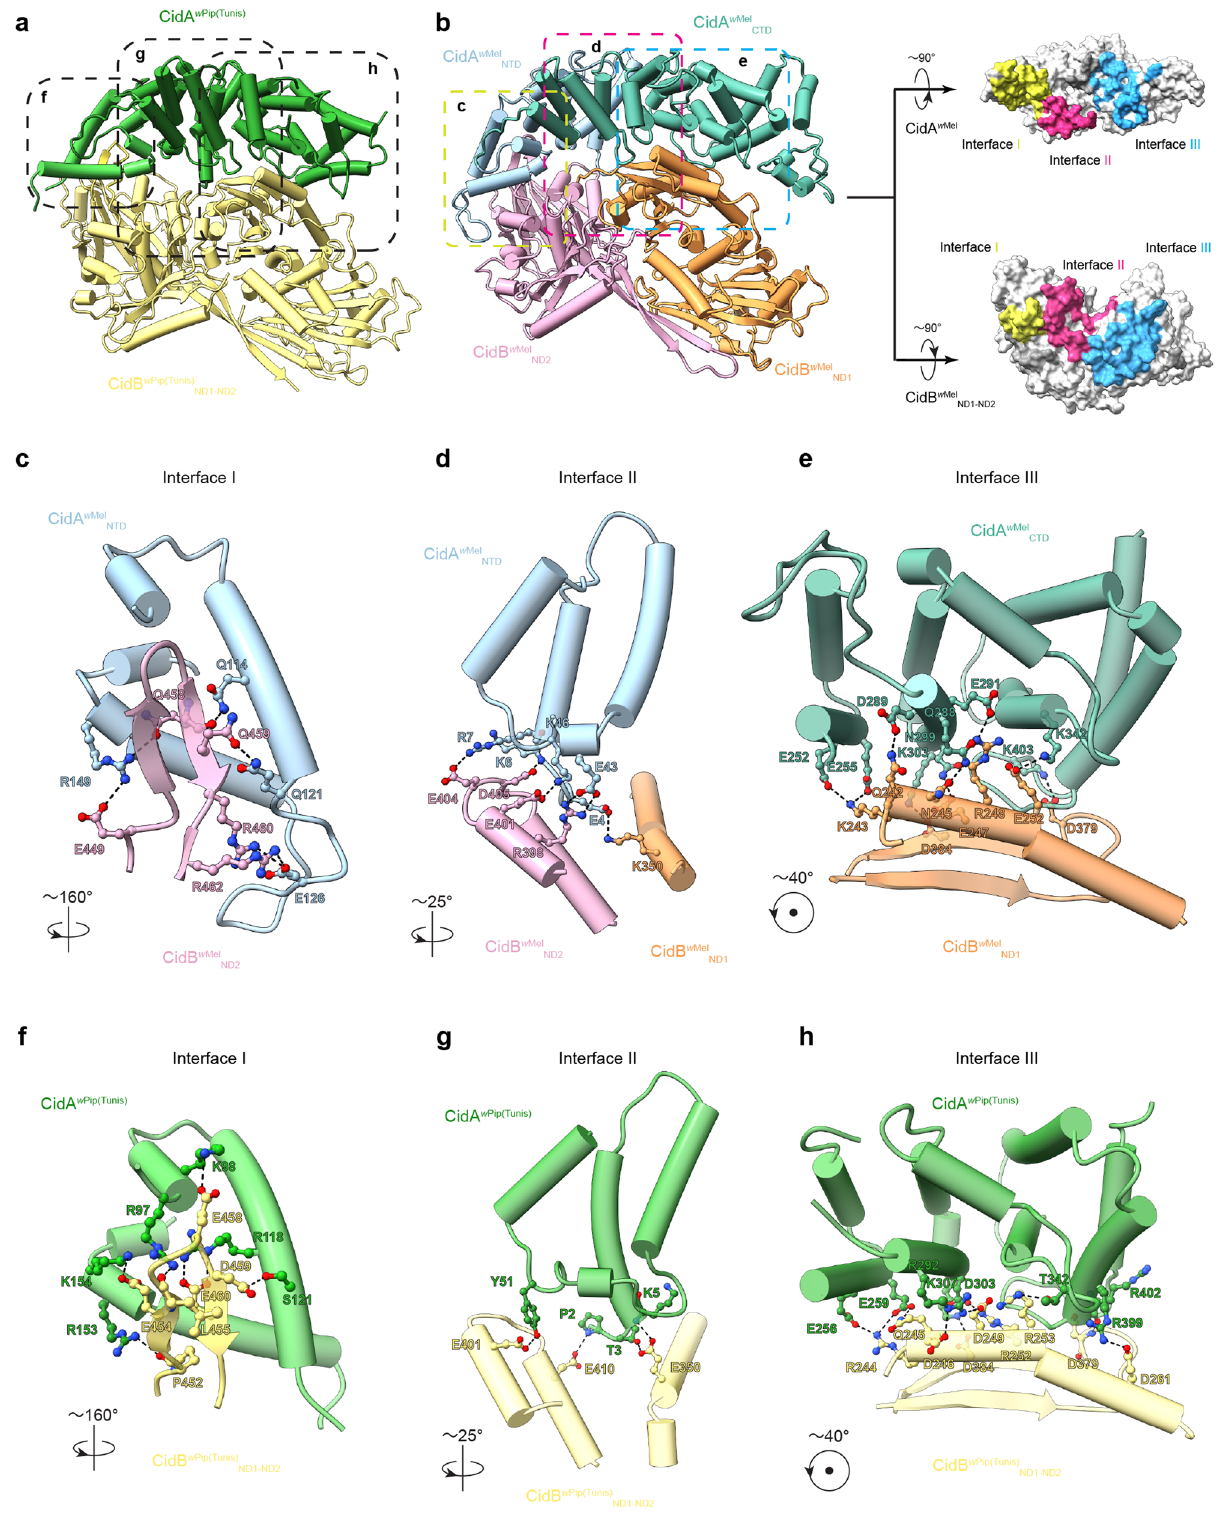
Fig. 2 CidA and CidB interact through a large conserved tripartite interface. a The structure of the CidA w Pip(Tunis) -CidB w Pip(Tunis) ND1-ND2 complex. CidA w Pip(Tunis) binds CidB w Pip(Tunis) ND1-ND2 through three regions (Interface I, II, and III). b A structural model of CidA w Mel in complex with CidB w Mel ND1- w Mel and CidB w Mel ND2 was generated by AlphaFold-Multimer. The tripartite interface between CidA ND1-ND2 is shown in yellow, magenta and cyan for Interface I, II, and III, respectively. c – e Each interface of the CidA w Mel -CidB w Mel ND1-ND2 complex involves a pair of structural motifs. Representative residues directly involving in the interaction are labeled and shown as balls and sticks. f – h The structural motifs at Interface I, II and III of the CidA w Pip(Tunis) - CidB w Pip(Tunis) ND1-ND2 complex are shown, with residues directly involving in the interaction labeled. NTD N-terminal domain; CTD C-terminal domain; ND nuclease